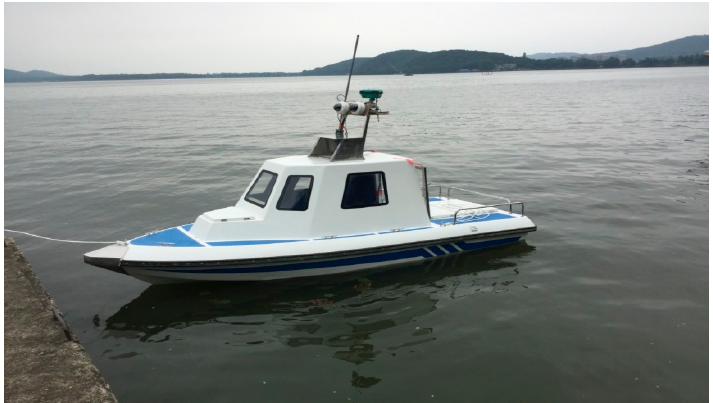
Figure 3. Our team’s experimental unmanned surface vehicle (USV) at East Lake.